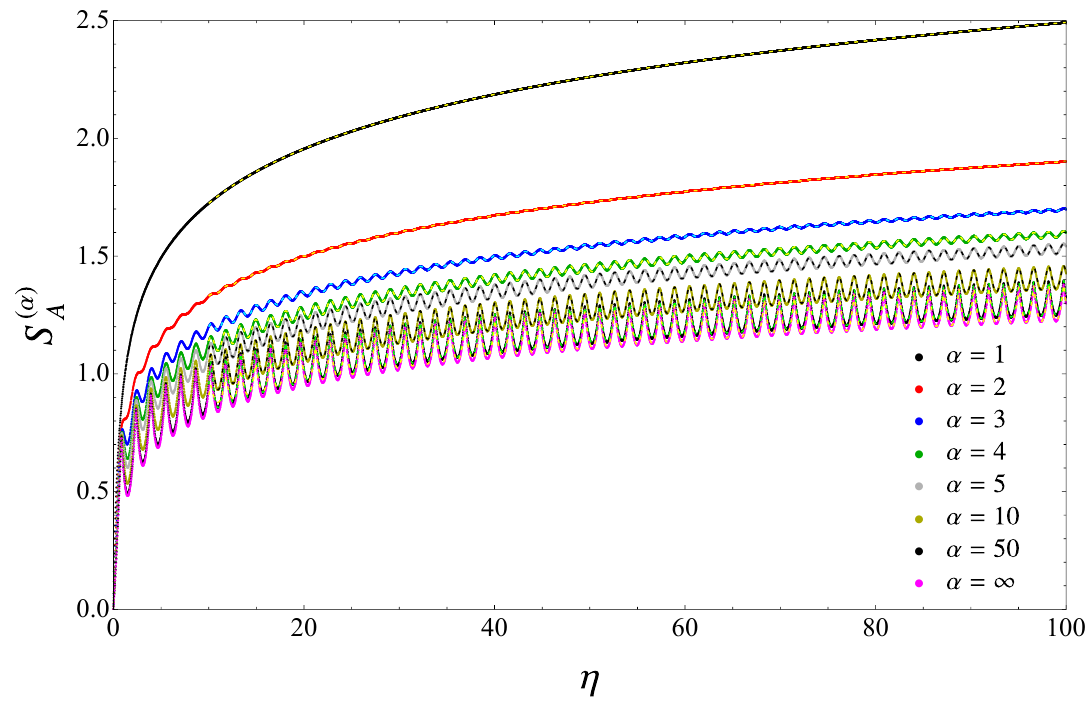
Figure 4. Entanglement entropies S ( α ) for different values of α . The dashed lines (shown only for A η > 10 ) correspond to the large η expansion given by (8.15), (8.17) and